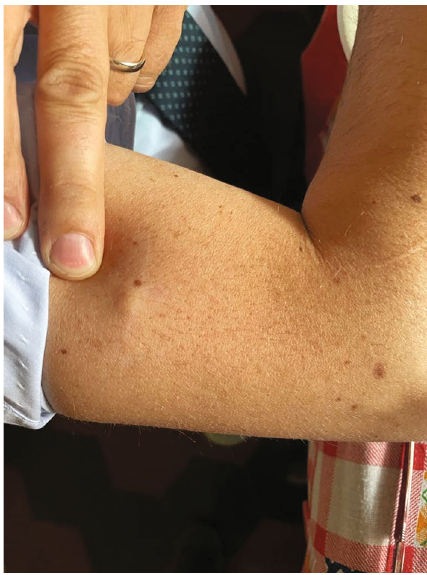
Figure 11: Patient (AF, 80 years) with dacryocystitis, basalioma, and blepharitis after Parvulan